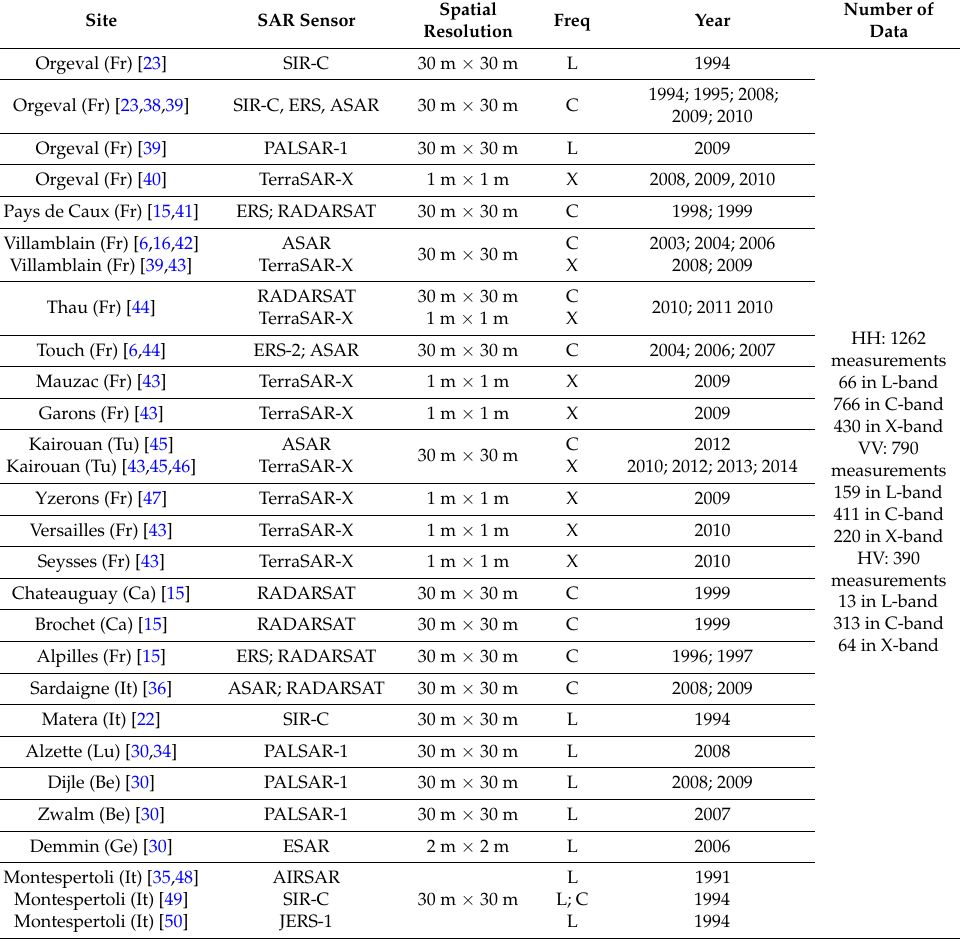
Table 1. Description of the dataset used in this study. “Fr”: France, “It”: Italy, “Ge”: Germany, “Be”: Belgium, “Lu”: Luxembourg, “Ca”: Canada, “Tu”: